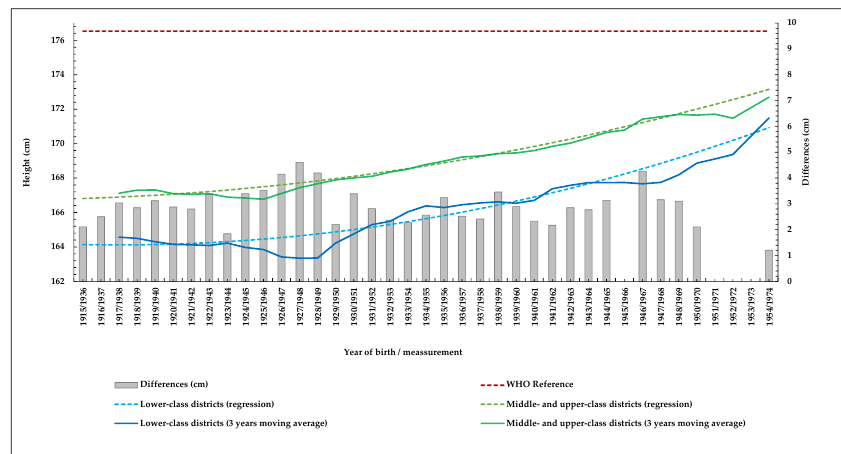
Figure 2. Secular trends in height in lower class districts, and middle- and upper-class districts, and annual di ff erences between them (Source: AGMG).